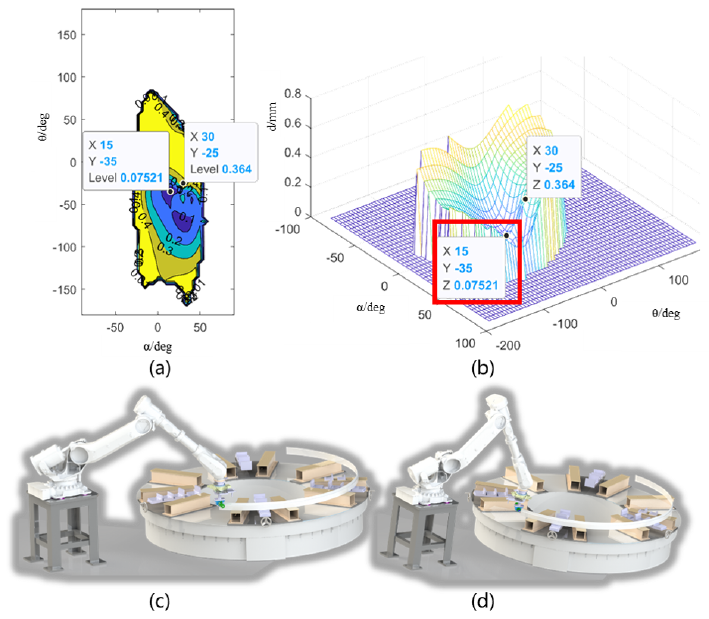
Figure 17. The result of traversal simulation of the two redundant degrees of freedom. ( a ) The contour sketch of the displacements; ( b ) the displacements under all degrees of the two redundant DOFs; ( c , d ) the robot postures before and after